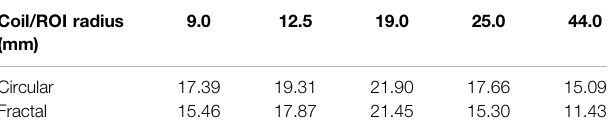
TABLE 4 | The SNR values for each 3D radial experimental data ROI shown in Figure 3 . The fi rst three ROIs in the table are the spherical ROIs, and the last two are the cylindrical ROIs. The noise ROI used for calculations is also given in Figure 3 as the spherical ROI above the coil plane. Coil/ROI radius (mm)